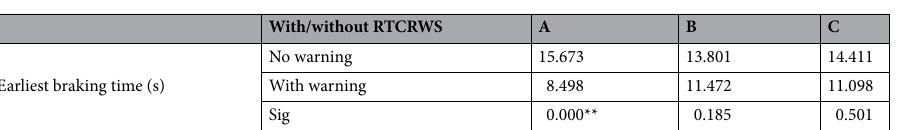
Table 1. Comparison of the earliest braking times. Sig . significance level of T-test. *Significant at 0.05 level. **Significant at 0.01